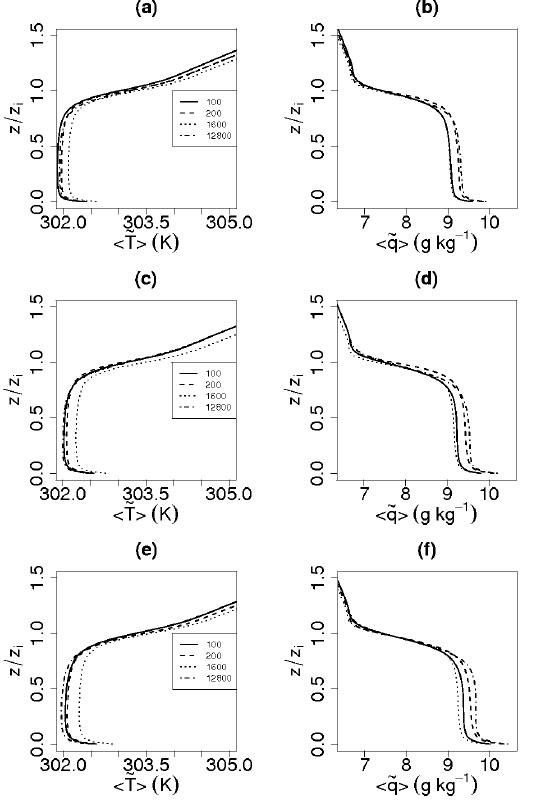
Fig. 12. Spatially averaged vertical scalar profiles for (left) air tem- perature [K] (right) specific humidity [gkg − 1 ] for (a, b) low, (c, d) intermediate and (e, f) high wind speeds.